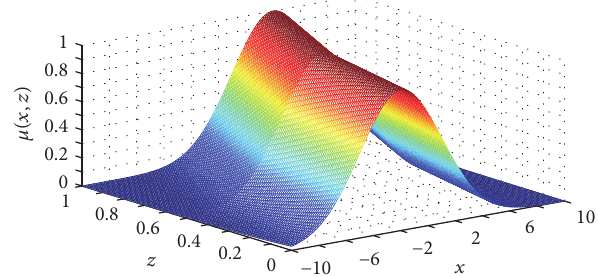
Figure 11: A three-dimensional fuzzy